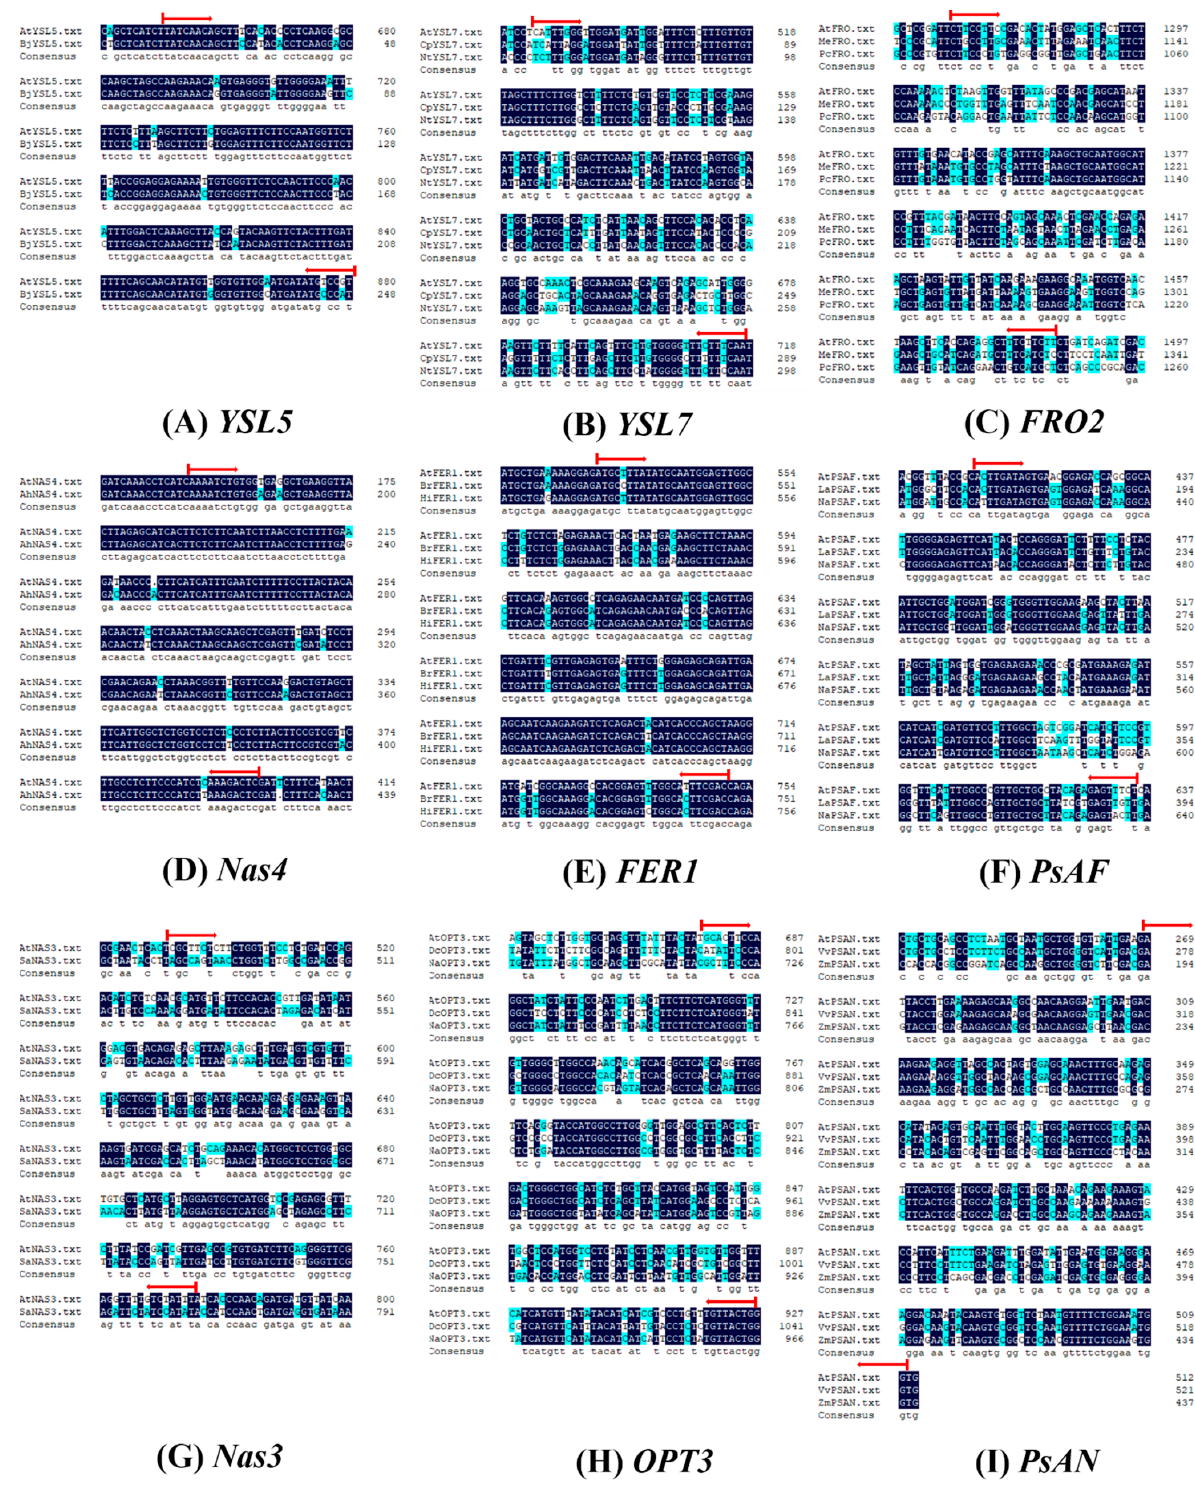
Figure 1. DNA sequence alignment diagrams for AtYSL5 and BjYSL5 ( A ); AtYSL7 , CpYSL7 , and NtYSL7 ( B ); AtFOR2 , MeFRO2 , and PcFRO2 ( C ); AtNAS4 and AhNAS4 ( D ); AtFER1 , BrFER1 , and HiFER1 ( E ); AtPsAF , LaPsAF , and NtPsAF ( F ); AtNAS3 and SaNAS3 ( G ); AtOPT3 , DcOPT3 , and NtOPT3 ( H ); AtPsAN , VvPsAN , and ZmPsAN ( I ). The alignment was obtained by using the DNAMAN software.